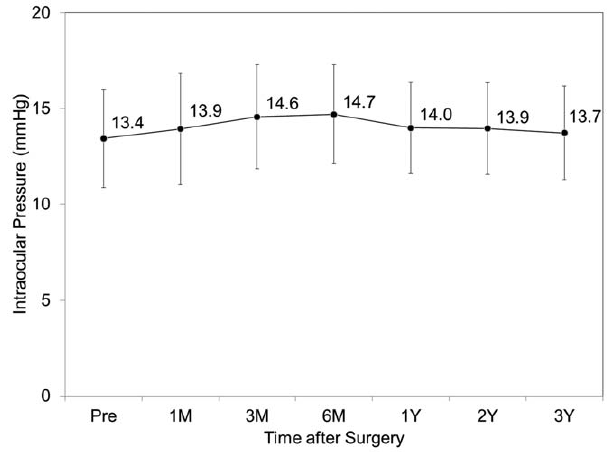
Figure 4. Time course of manifest spherical equivalent after toric implantable collamer lens implantation. D = diopter, M=month, Y=year